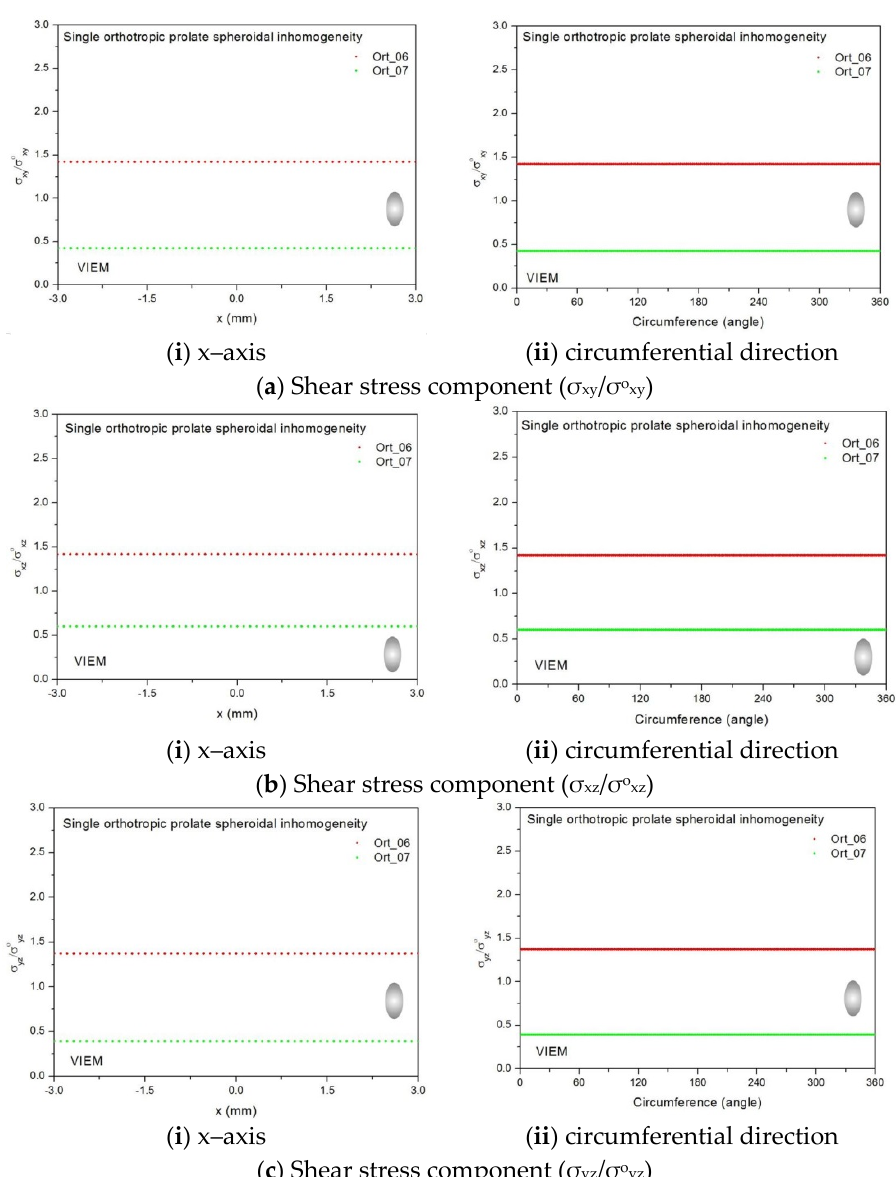
Figure 27. VIEM results for the normalized shear stress components ( a ) σ xy / σ o xy , ( b ) σ xz / σ o xz and ( c ) σ yz / σ o yz along ( i ) the x–axis inside and ( ii ) the circumferential direction of the orthotropic prolate spheroidal inclusions (Ort_06 and Ort_07) with a/b = c/b = 0.5 (b = 6 mm) under remote shear loading ( σ o xy , σ o xz and σ o yz